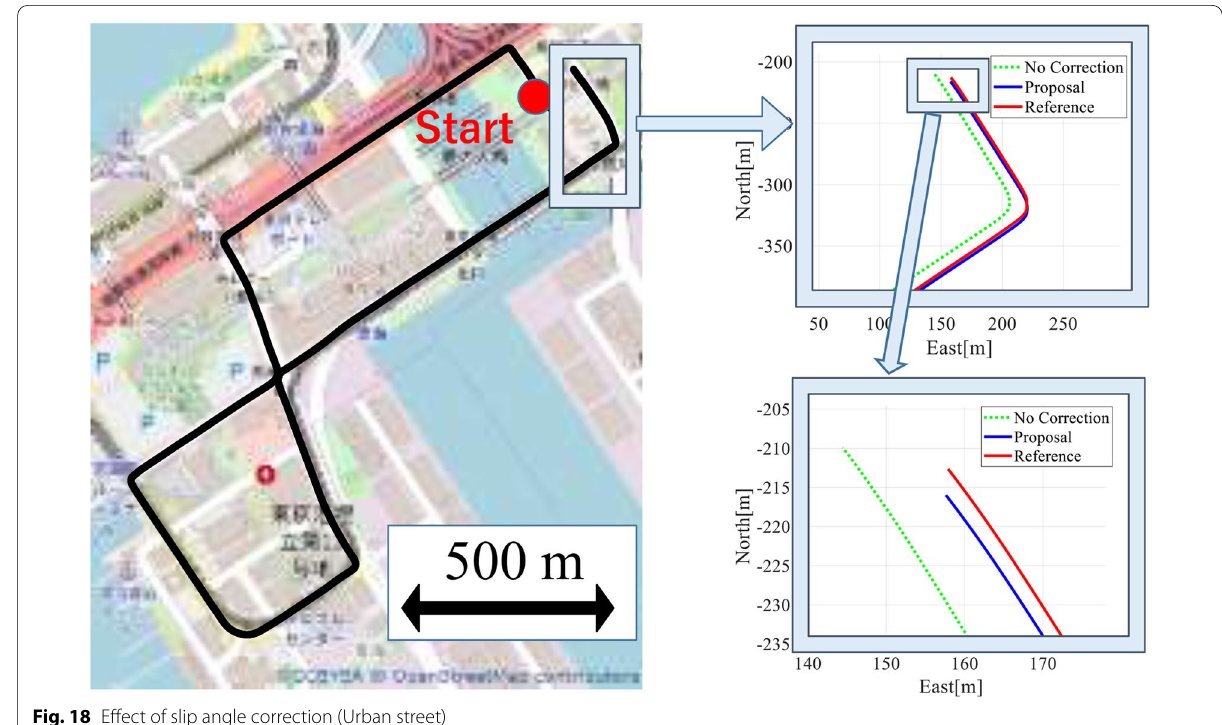
Fig. 18 Effect of slip angle correction (Urban street)